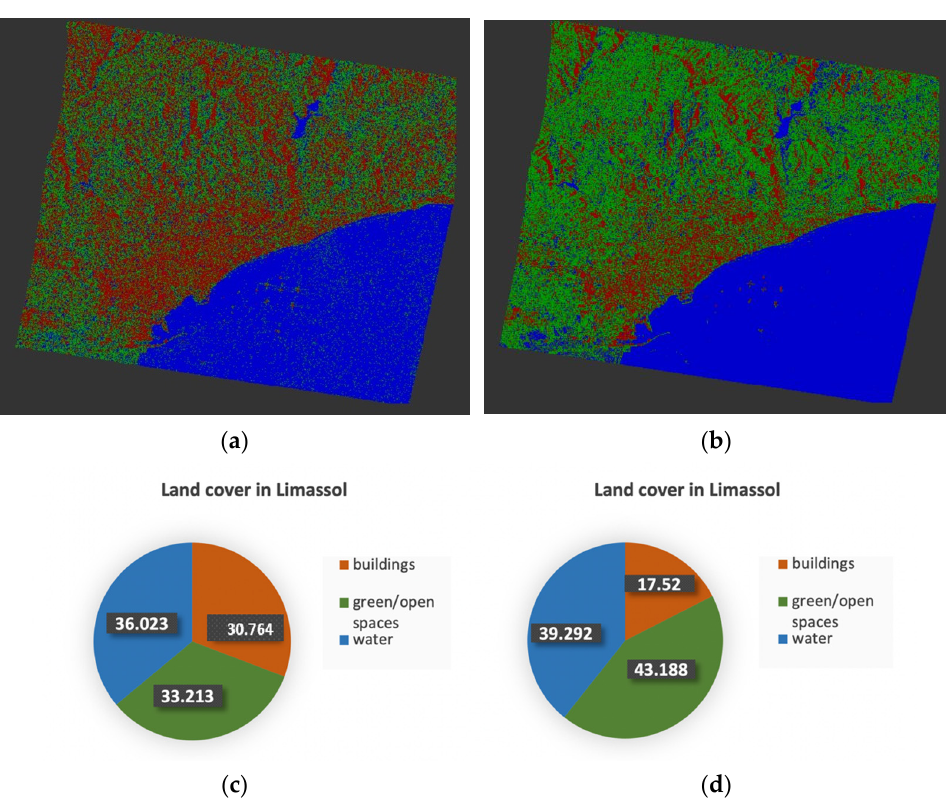
Figure 6. Comparison of Supervised Classifiers in Limassol: ( a ) Result of Random Forest Classifier; ( b ) Result of Maximum Likelihood Classifier; ( c ) Percentage of Land Cover—RF; ( d ) Percentage of Land Cover—M.